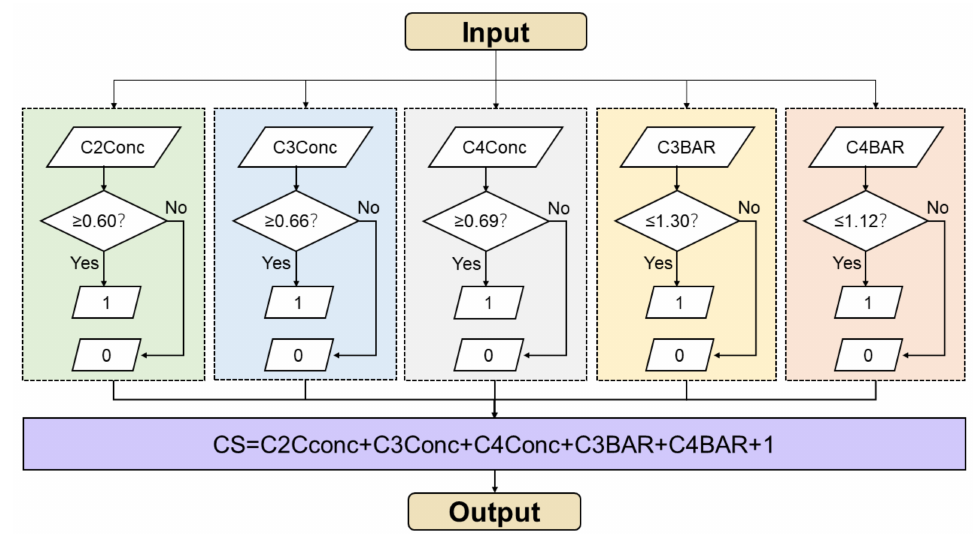
Figure 3. Workflow of the AI system to assess the CVM stage. Measurements are input and reassigned according to thresholds. The CVM stages were calculated and